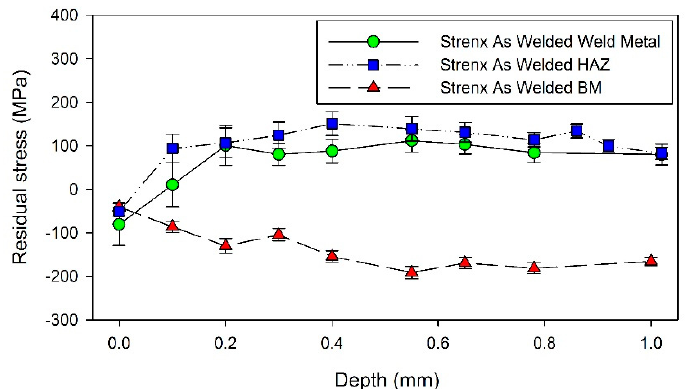
Figure 9. Residual stress in the zones of as welded machined fatigue test specimen, measured at φ = 0° (axial residual stresses).